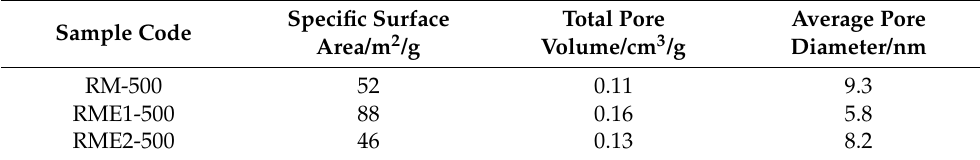
Figure 1. ( a ) N 2 adsorption–desorption isotherms and ( b ) the corresponding pore size distribution curves of RME and RM samples. The isotherms and the pore size distribution curves have been shifted by 5 and 10 cm 3 /g and 0.04 and 0.08 cm 3 /g · nm, respectively, for more clarity. Table 2. Textural properties of the RME and RM samples from the N 2 physisorption